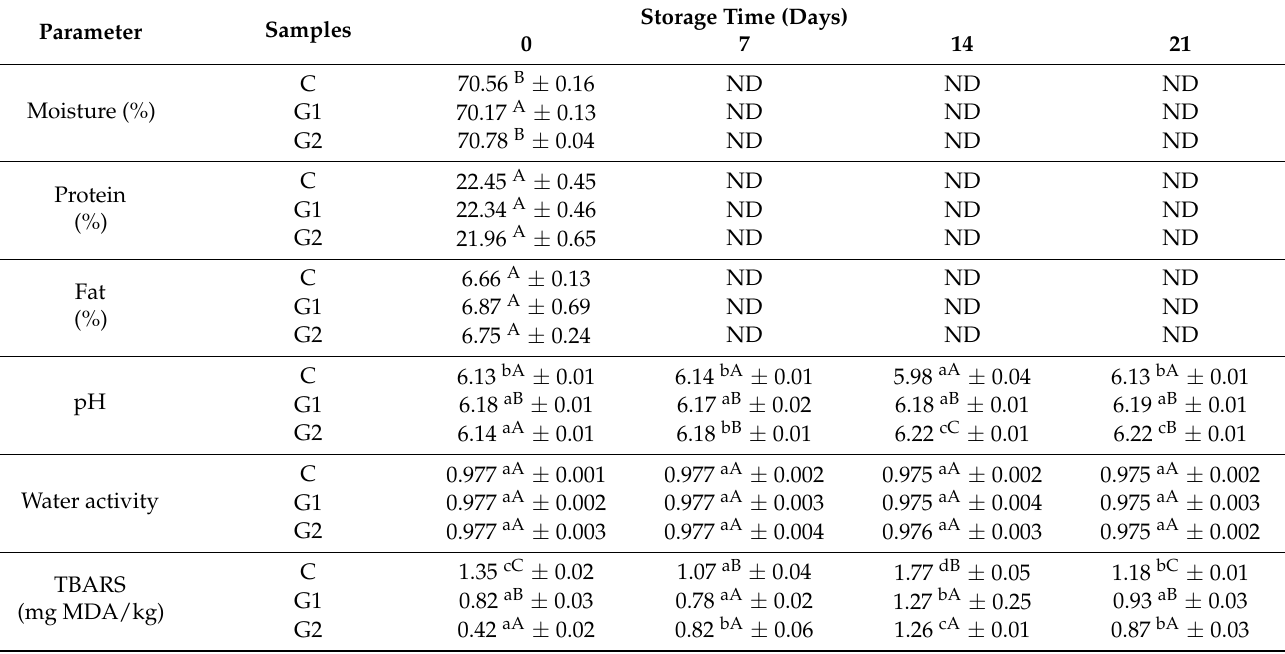
Table 2. Proximate composition of pork meatloaves and the effect of ginger rhizome and storage time on the pH, water activity, and TBARS values of pork